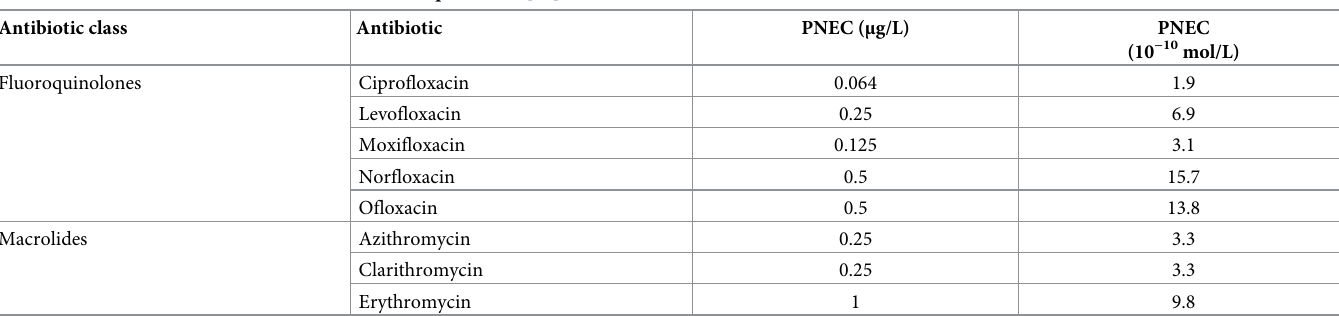
Table 6. Modelled PNECs for macrolides and fluoroquinolones